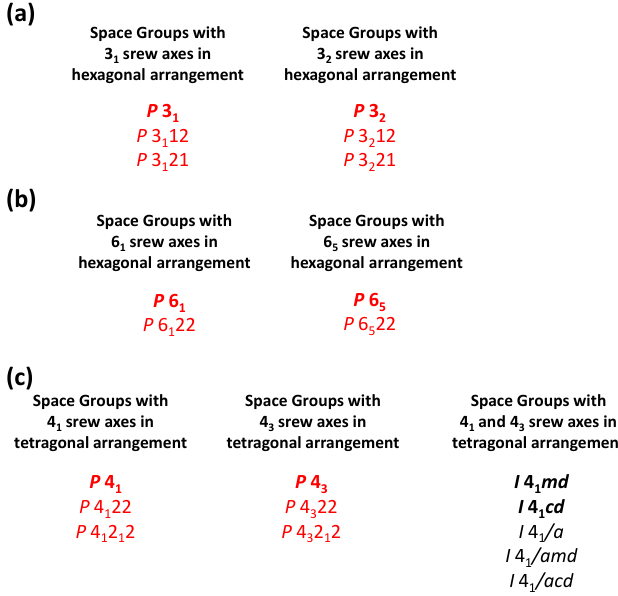
Figure 2. List of space groups exhibiting ( a ) 3 n screw axes in hexagonal arrangement, ( b ) 6 n screw axes in hexagonal arrangement and, ( c ) 4 n screw axes in tetragonal arrangement. Space groups in red color are chiral. Space groups in bold are polar. No space groups combining 3 1 and 3 2 screw axes or 6 1 and 6 5 screw axes exist.